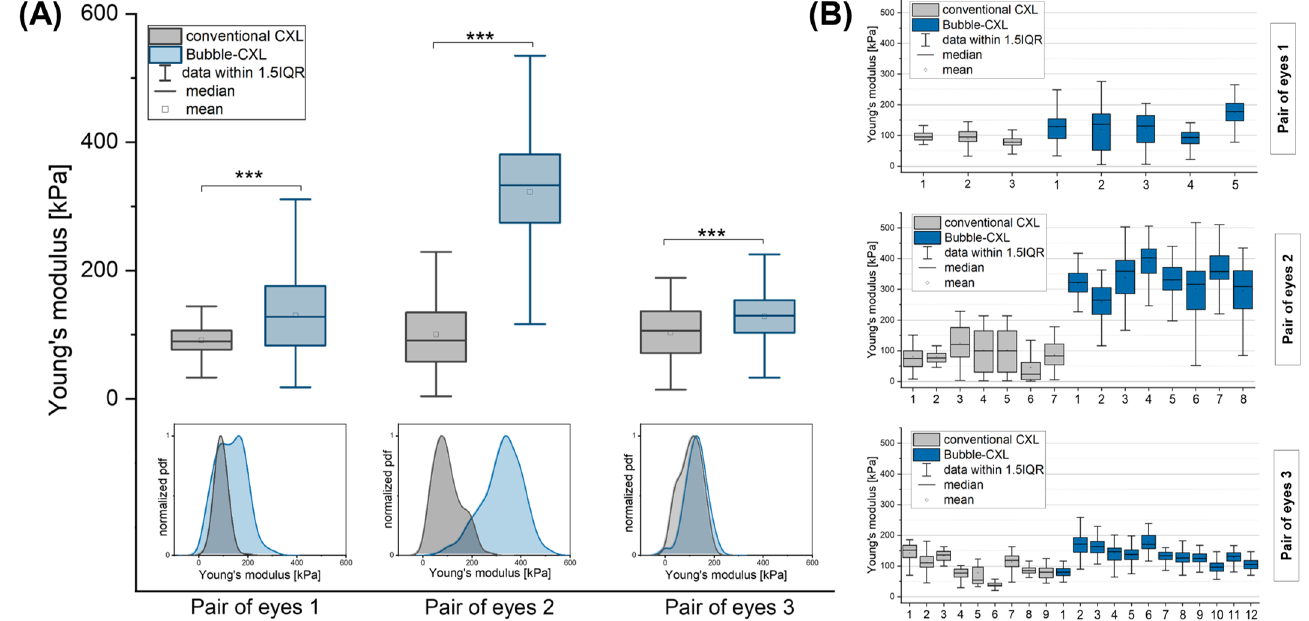
Figure 3. ( A ) Boxplot diagrams of calculated Young’s modulus values of all recorded force–distance curves of corneas treated with conventional CXL versus corneas treated with Bubble-CXL for three pairs of eyes. Corneas treated with Bubble-CXL show a significantly higher stiffness ( p ≤ 0.001) (indicated with ***) than those treated with conventional CXL. The experimental probability density functions (pdfs) of Young’s moduli show a clear shift to higher Young’s moduli for Bubble-CXL treatment. ( B ) Young’s modulus distributions of force volume measurement (8 × 8 force–distance curves) were recorded at various positions on cornea samples of pairs of eyes 1–3. Table 1. Summary of Young’s moduli (average ± standard deviation) of corneas from three pairs of eyes treated either with conventional CXL or Bubble-CXL. The sample size describes the sum of force–distance curves recorded on various sample positions (number of positions) used for Young’s modulus calculation.